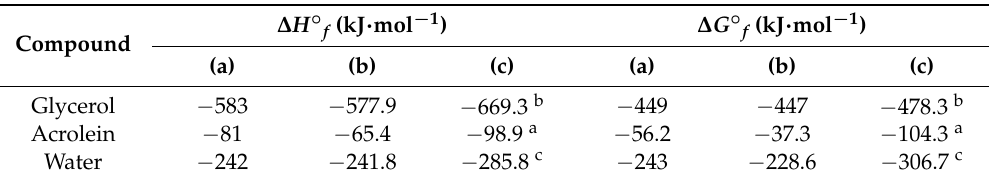
Table 4. Comparison of thermodynamic data in the gaseous and liquid phases of compounds involved in acrolein production from